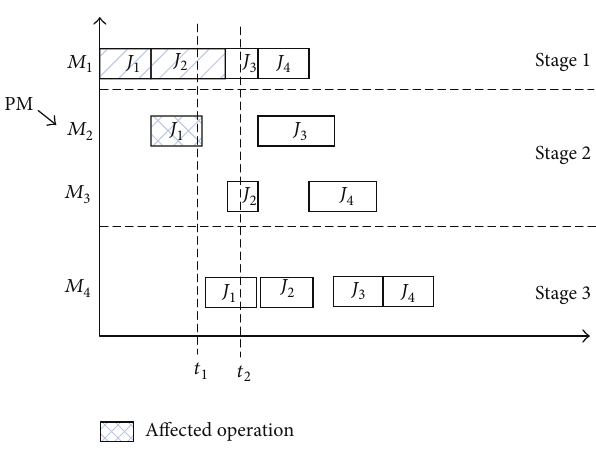
Figure 2: Situation 1 of PM